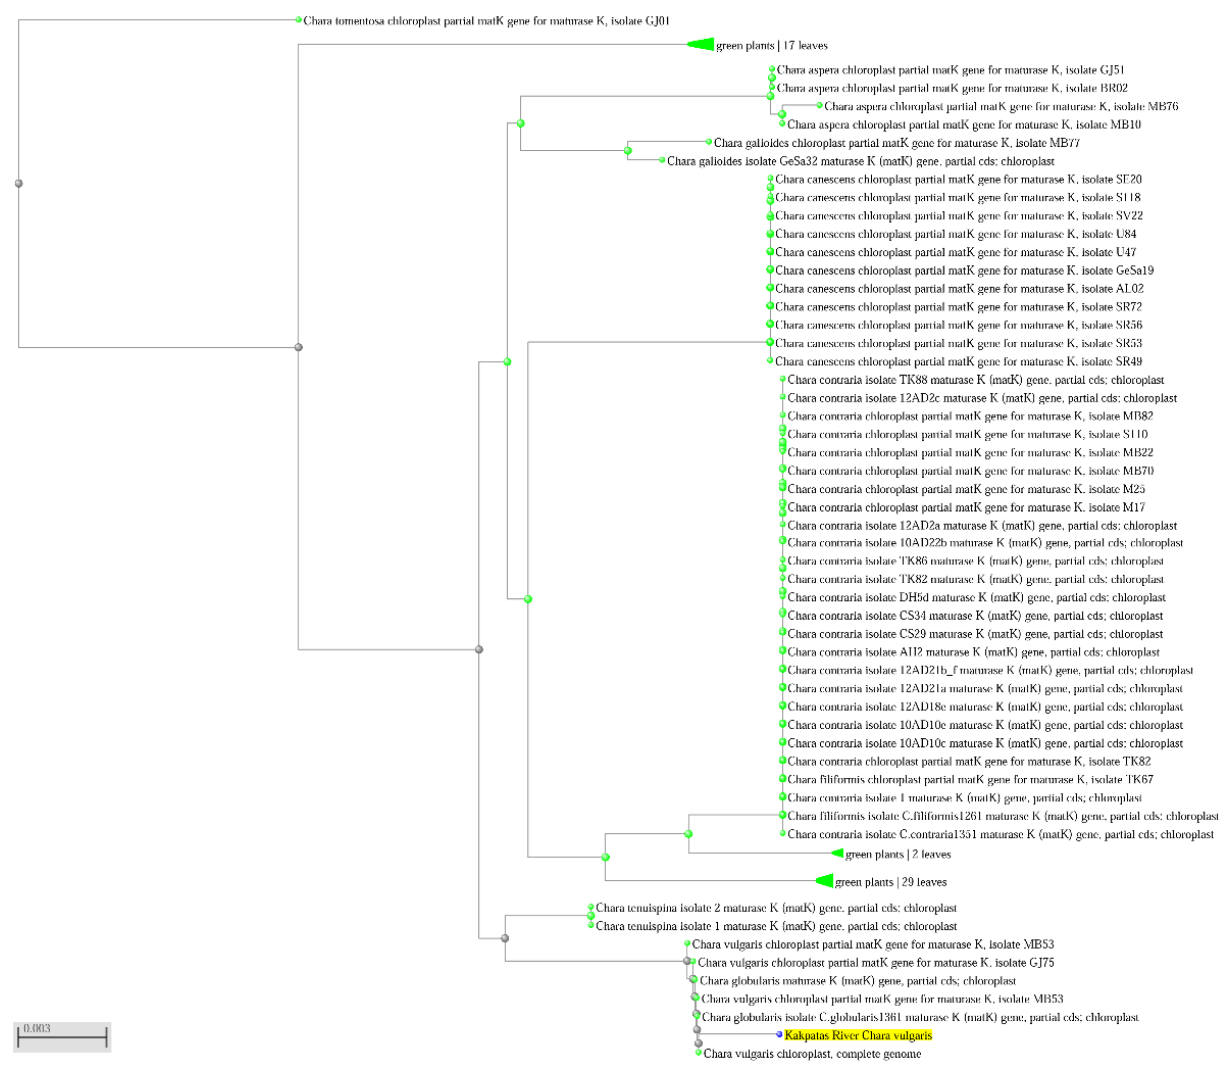
Figure 6. Maximum Likelihood tree of the mat K gene of Chara spp. Bootstrap values above 97 are included. The scale bar indicates 0.3% sequence divergence. Sample AA 11-2 of Chara vulgaris highlighted by yellow is from Kakpatas River, site 11; sequences were obtained from herbarium material. The taxon name and NSBI GenBank number are provided.